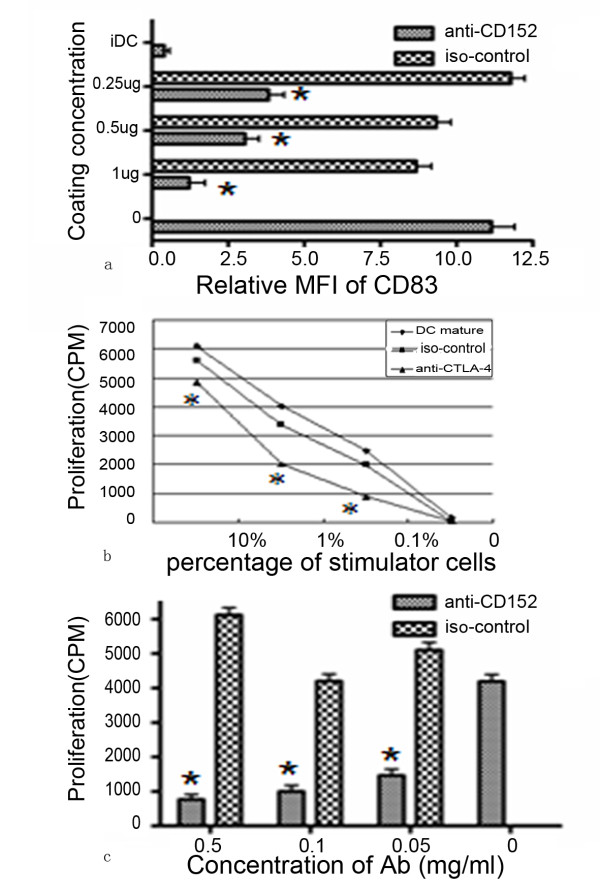
Cross-linking of CTLA4 inhibits DC maturation (A), the mixed lymphocyte response (B), and antigen presentation (C). *: P < 0.05 anti-CTLA4 antibody vs control antibody. A representative of three experiments is shown. A: Relative mean fluorescence intensity (MFI; MFItreated - MFIiDC) of CD83 was measured. DCs were seeded in wells coated with anti-CTLA4 antibody or isotope control antibody at the indicated concentrations, and mature DCs were used as the positive control. B: Mature DCs after challenge in plates coated with anti-CTLA4 or control antibody were used as the stimulators and allogeneic PBMC-derived T lymphocytes as the responders. DCs and T cells were mixed in different ratios with a constant number of T cells (2 × 105 cells/well). T-cell proliferation was measured in triplicate by the incorporation of [3H]-thymidine and is expressed as cpm. C: Effect of CTLA4 cross-linking on the presentation of PPD to specific T-cell lines. After PPD pulsing, DCs were further cultured with maturation-inducing stimuli in plates coated with anti-CTLA4 antibody or control antibody at the indicated concentrations. The cells were then washed extensively and mixed with PPD-specific autologous T-cell lines. Proliferation was assessed as [3H]-thymidine uptake.